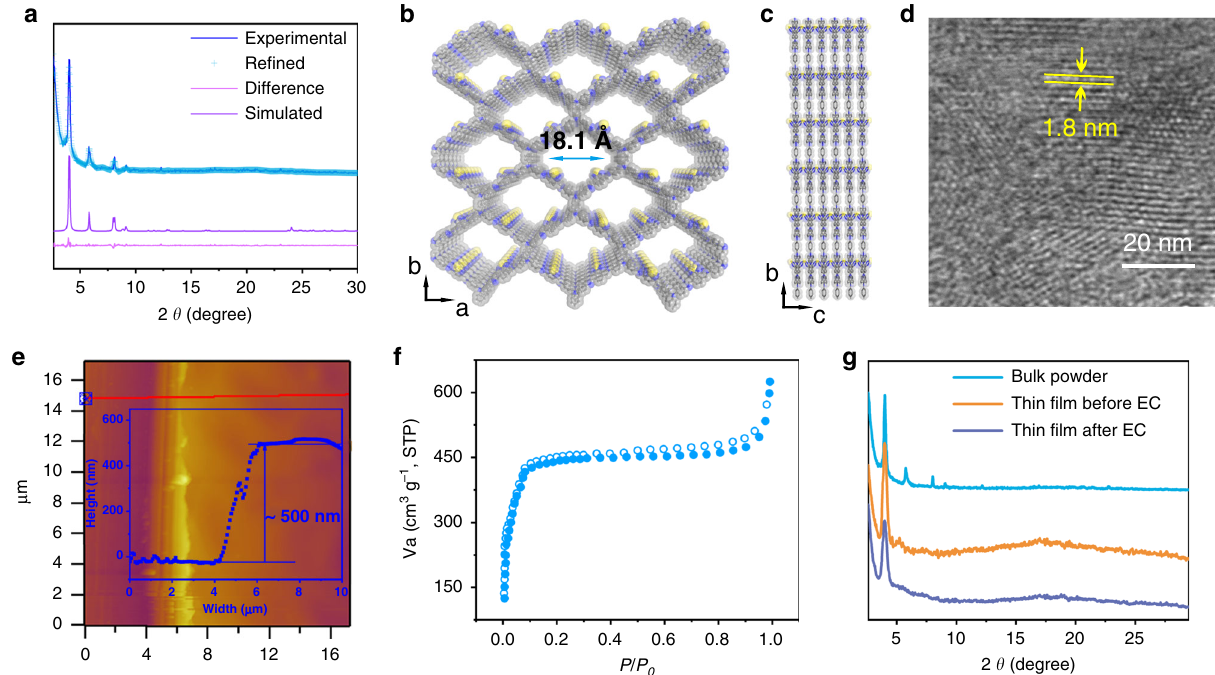
Fig. 2 Structural aspects of EC-COF-1. a Observed (purple line), Pawley re fi nement (red cross), difference (blue line), and eclipsed AA simulation (green line) PXRD patterns. Simulated structure of EC-COF-1: b top and c side views. (Colours: blue — N, grey — C, yellow — S). d HR-TEM image. e AFM image with ~500 nm height. Porous properties: f N 2 sorption isotherm (solid iris blue ball for adsorption, and hollow iris blue ball for desorption). g The X-ray diffraction pattern of the as-synthesised bulk powder (black line), thin fi lm before EC (red line) and thin fi lm after EC (blue line) of EC-COF-1.